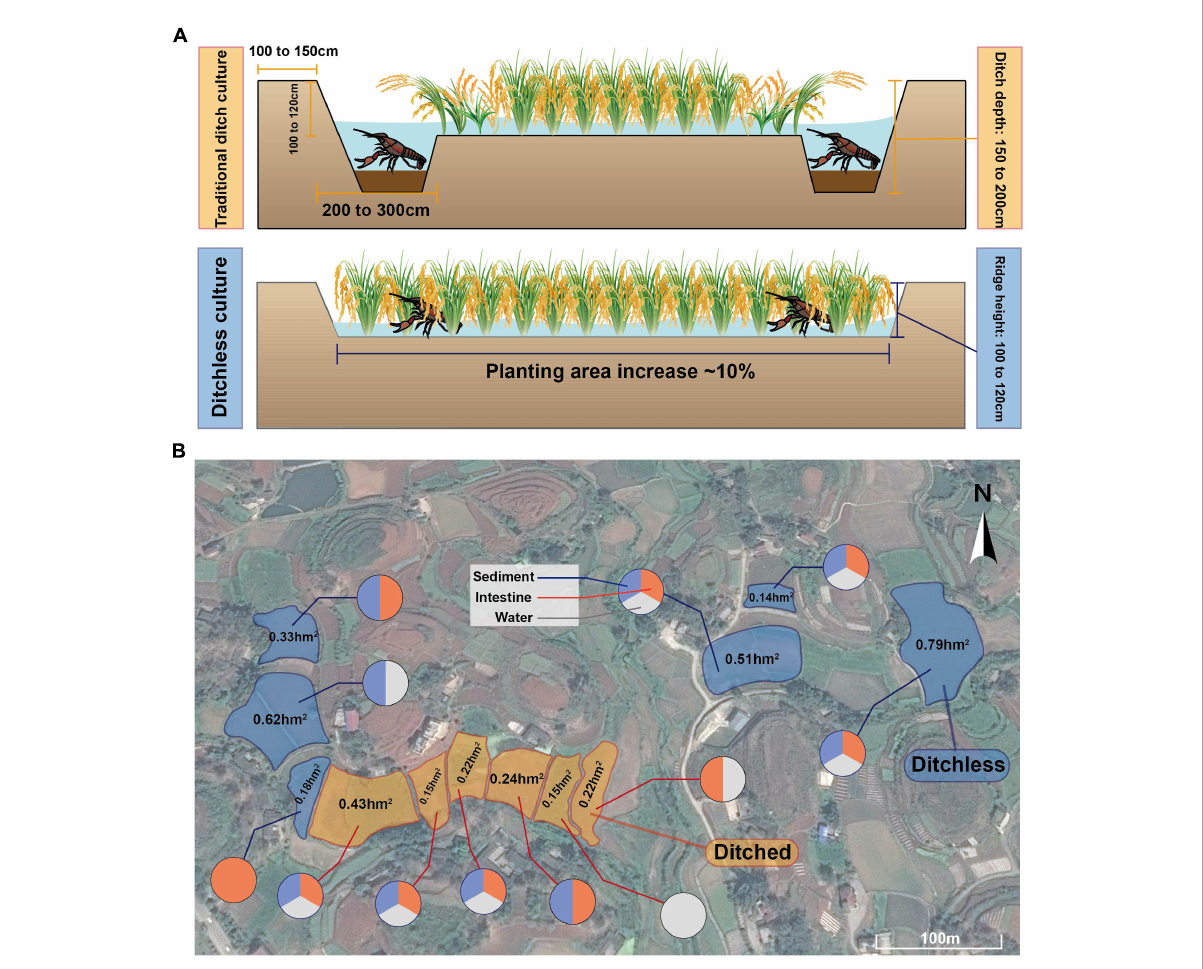
FIGURE1 Sample collection site in Yibin, Sichuan, China. (A) Schematic diagram of ditched and ditchless rice-shrimp co-culture systems. (B) Specific distribution of sampling points and type of samples